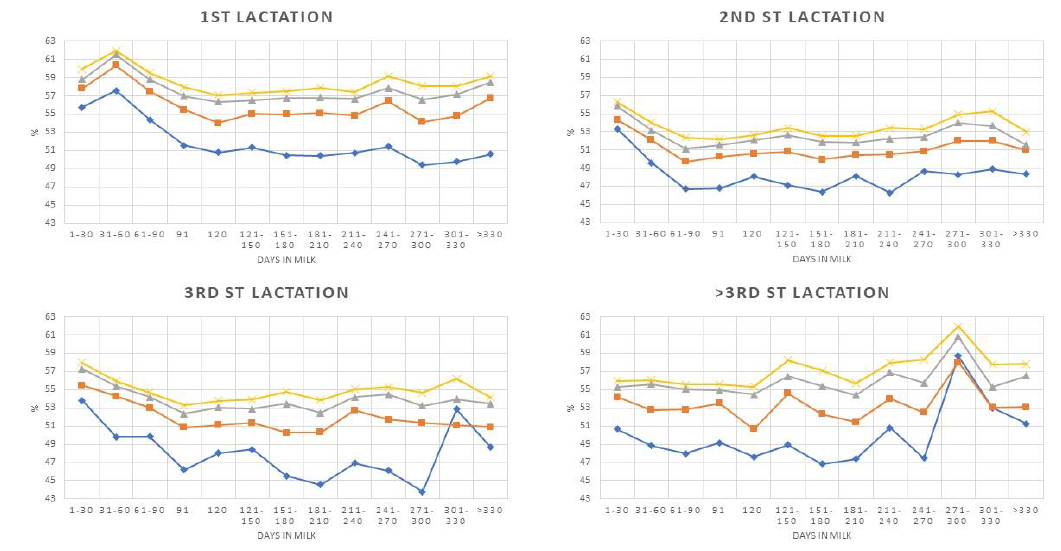
 ≤ 150,000 cells / m;  ≤ 200,000 cells / m). 